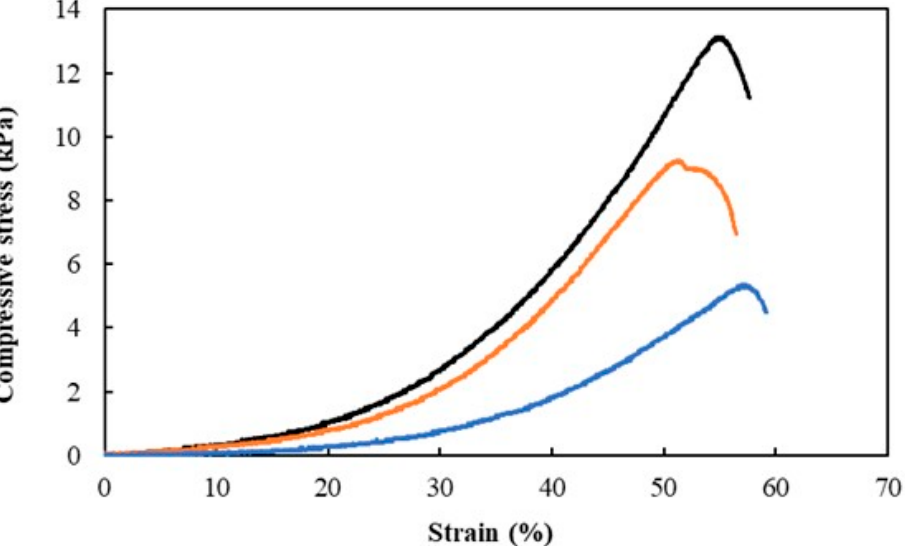
Figure 2. Compression stress–strain curves of Na5 1 * (blue line), Na5 1 * 4 (orange line), and Na5 1 * 6 (black line) hydrogels.